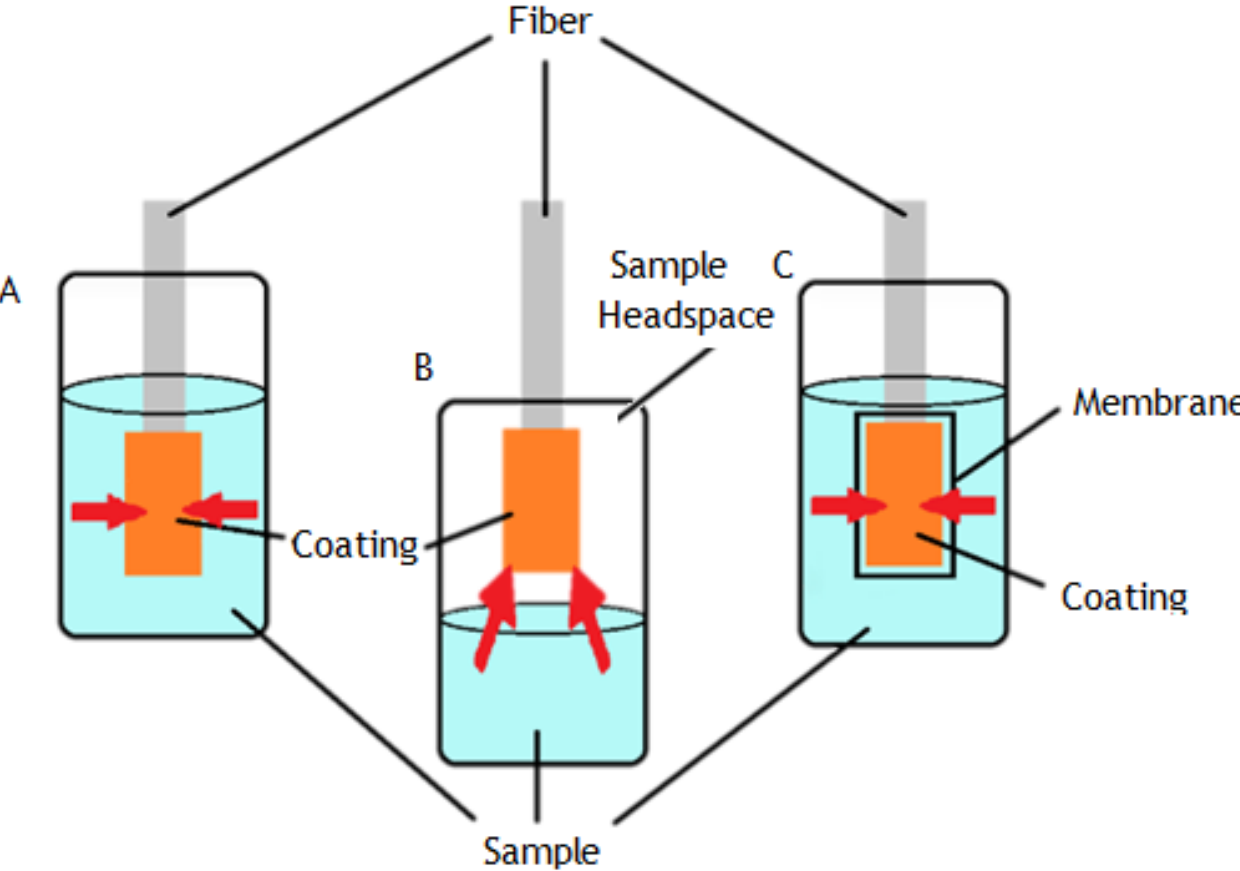
Figure 1. SPME extraction modes: ( A ) Direct immersion; ( B ) headspace mode; ( C ) membrane pro- tection.